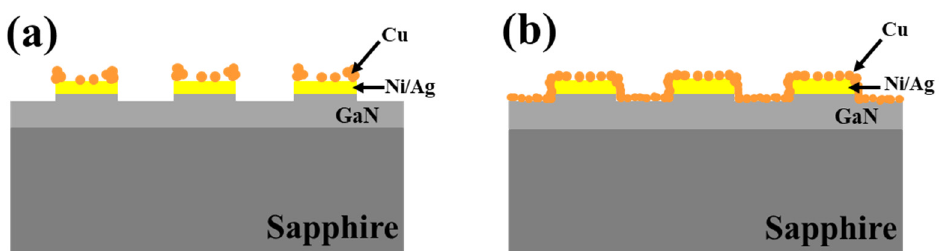
Figure 9. Schematic illustrations for Cu distributions in the GaN MacEtch process with different etchants where the HF concentration is: ( a ) low; ( b ) high.